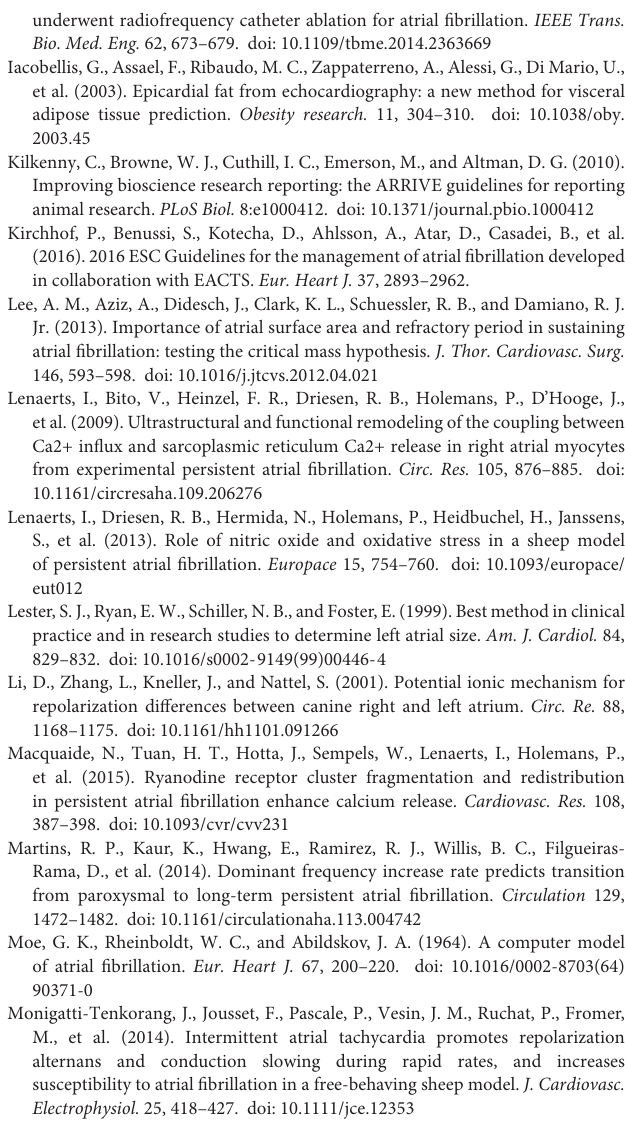
Supplementary Figure 1 | A typical parasternal long axis (PLAX) view obtained by 2D echocardiography from a sheep. Left atrial (LA) anteroposterior diameter was measured during ventricular systole. Epicardial fat pad thickness (EFT) was measured anterior to the right ventricle using the atrioventricular groove as a